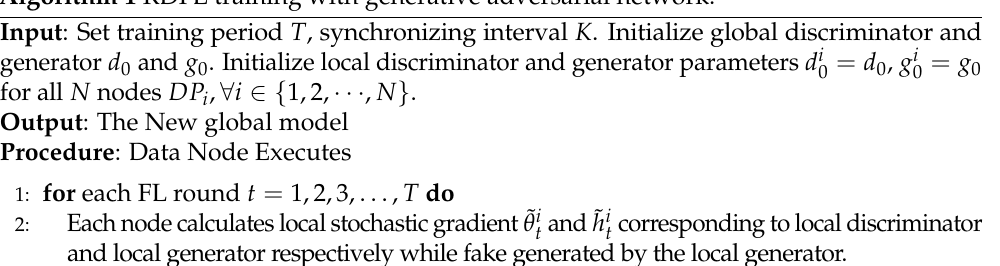
Figure 3. Ring decentralized federated learning. Algorithm 1 RDFL training with generative adversarial